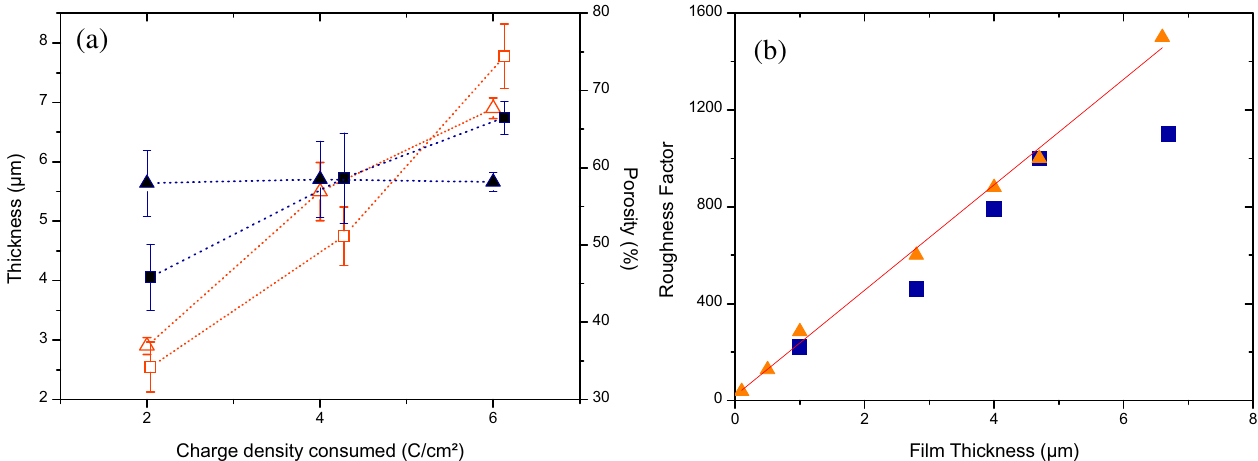
Fig. 4. (a) Evolution of film thickness (empty marks) and porosity (full symbols) of nanoporous structure deposited on FTO glass (squares) and ZnO:Al (triangles) with charge density consumed. (b) Evolution of the roughness factor of nanoporous films deposited on FTO glass (filled squares) on ZnO:Al (empty triangles) with the film